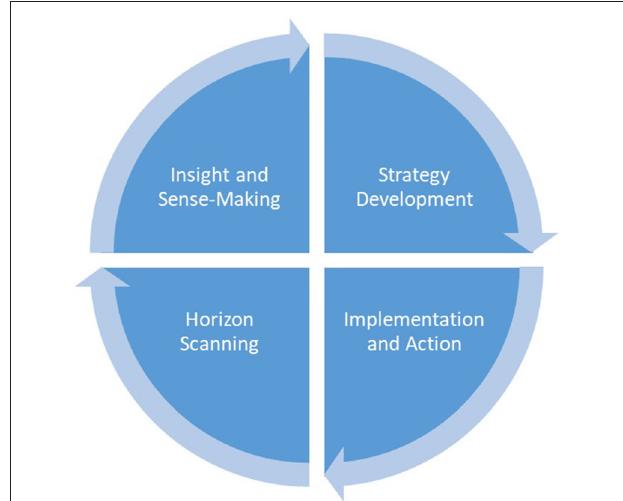
FIGURE 1 | Foresight